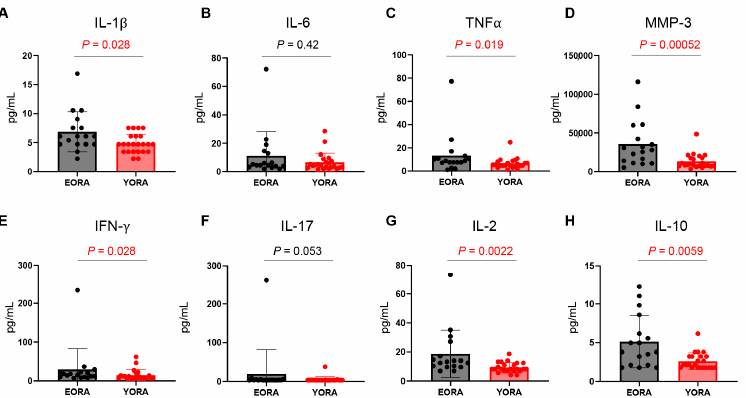
Figure 1. Comparison of plasma protein levels between elderly-onset rheumatoid arthritis (EORA) and young-onset RA (YORA). Plasma protein levels were compared between EORA ( n = 17) and YORA ( n = 23) groups. Data are shown as means ± SD. Statistical significance was calculated using unpaired two-tailed Student t-tests or Mann–Whitney U tests. ( A ) IL-1 β , ( B ) IL-6, ( C ) tumor necrosis factor (TNF) α , ( D ) matrix metalloprotease (MMP)-3, ( E ) interferon (IFN)- γ , ( F ) IL-17, ( G ) IL-2, and ( H )